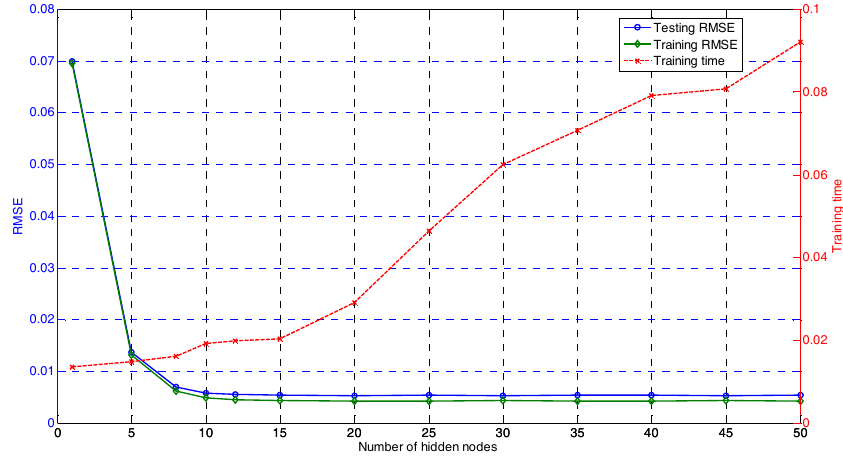
Figure 6. Selection of the hidden nodes number.